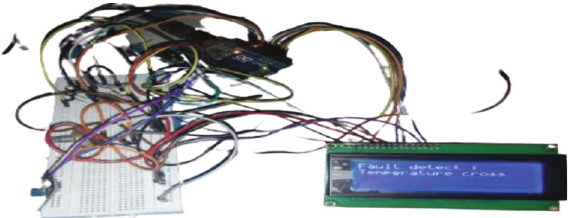
Figure 8: Real-time photo of overtemperature condition.